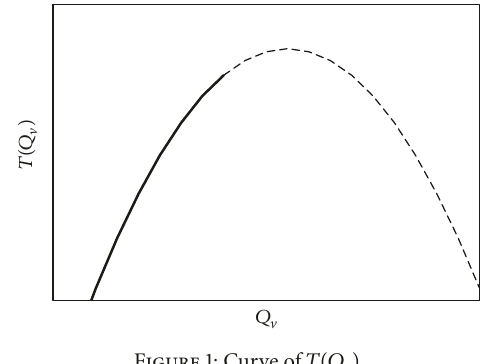
Figure 1: Curve of 𝑇(𝑄 V )